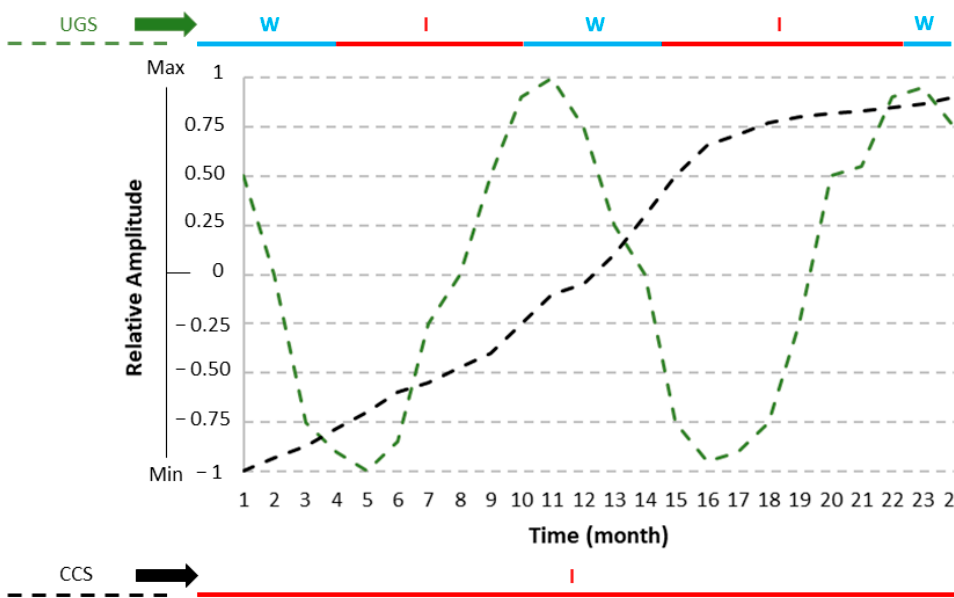
Figure 3. The theoretical course of the injection (red color) and withdrawal (blue color) cycle at an underground gas storage (green color) and the theoretical CO 2 injection profile of a CCS activity (black color).